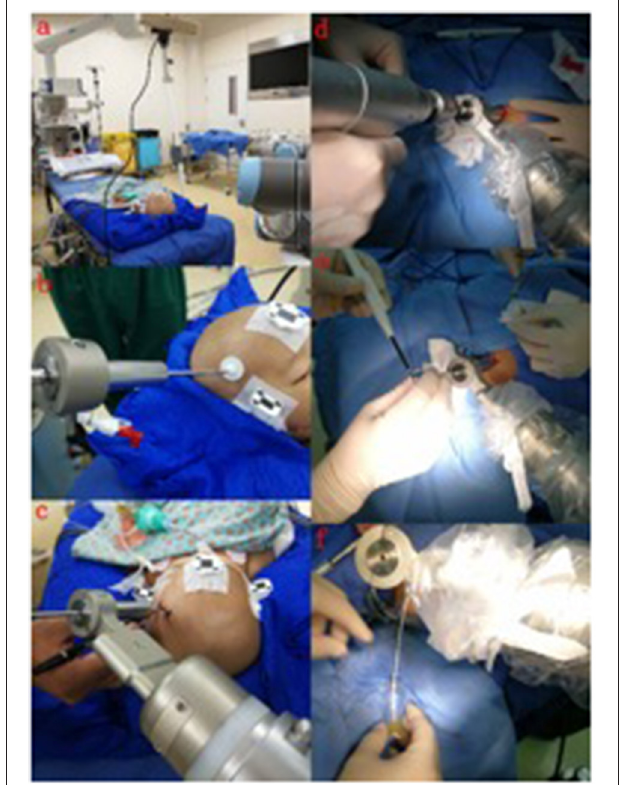
FIGURE 3 | The process of implantation. (a) The optical frame marker was detected; (b) the arm repositioned itself; (c) the scalp entry points were marked; (d) burr-hole drilling was performed under the guidance of the robotic arm; (e) electrocoagulation punctures in the dura mater; (f) fluid can be seen flowing out after the drainage tube was implanted in the target